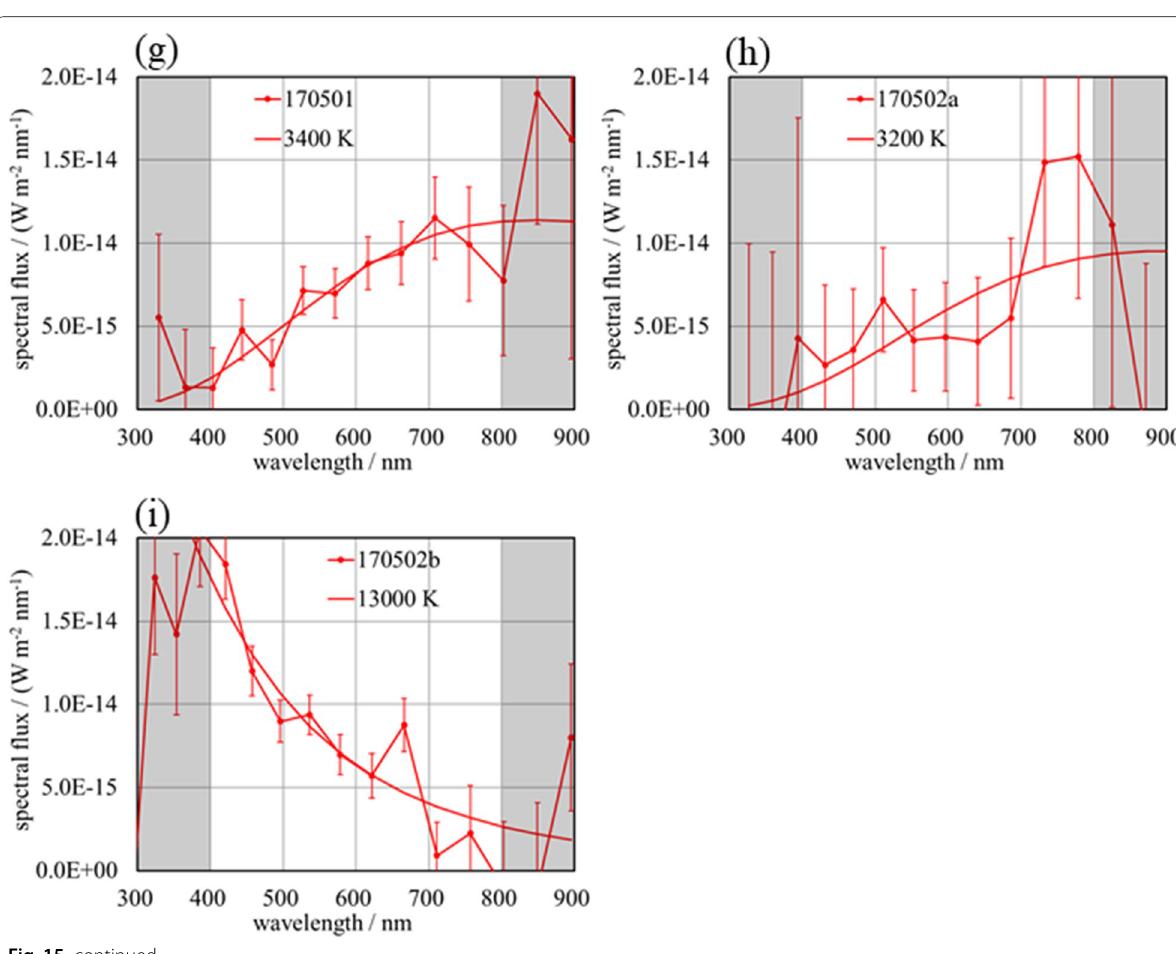
stars. The intense blue light of about 400 nm in wave- length, for example, contaminates the spectral image of 800 nm importantly. Though we corrected the 2nd-order image, the brightness ratio of the 2nd-order to the 1st- order images (Fig. 6a) used in the correction may depend on the image position in a frame. If so, the dependency would cause non-negligible